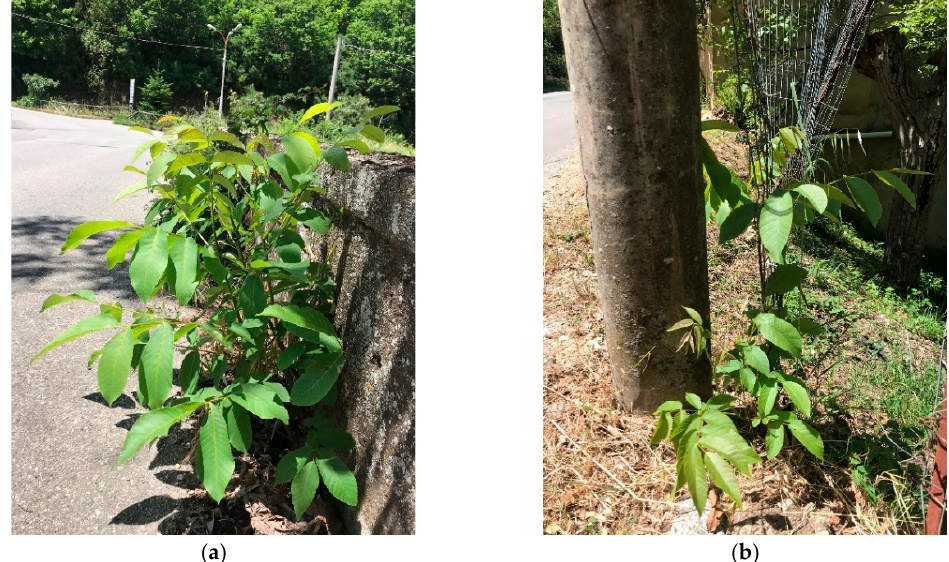
Figure A7. Juveniles of Juglans regia L. recorded along the roadside in Reggio Calabria province. ( a ) in Solano; ( b ) in Melia di Scilla (Photographs VLA Laface).